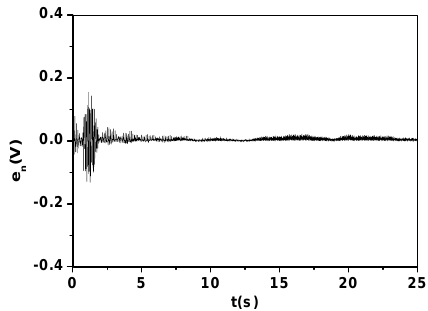
Fig. 5. Error evolution – NLMS algorithm applied to case C 1 .